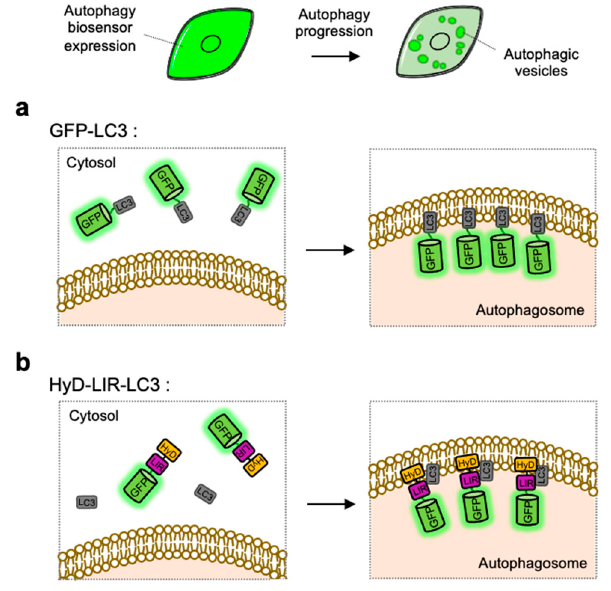
Figure 2. Detection of autophagic vesicles by single FP-tagged light chain 3 (LC3) or LC3 interacting region (LIR) domain. When autophagy is induced, single green fluorescent protein (GFP)-tagged LC3 or LIR domains can change its distribution from whole cell area to autophagic vesicles displaying as bright green puncta. ( a ) Scheme of the GFP-LC3 before and after autophagy induction. ( b ) Scheme of the hydrophobic domain (HyD)-LIR-LC3 before and after autophagy induction. LIR: LC3-interacting region, HyD: hydrophobic domain.